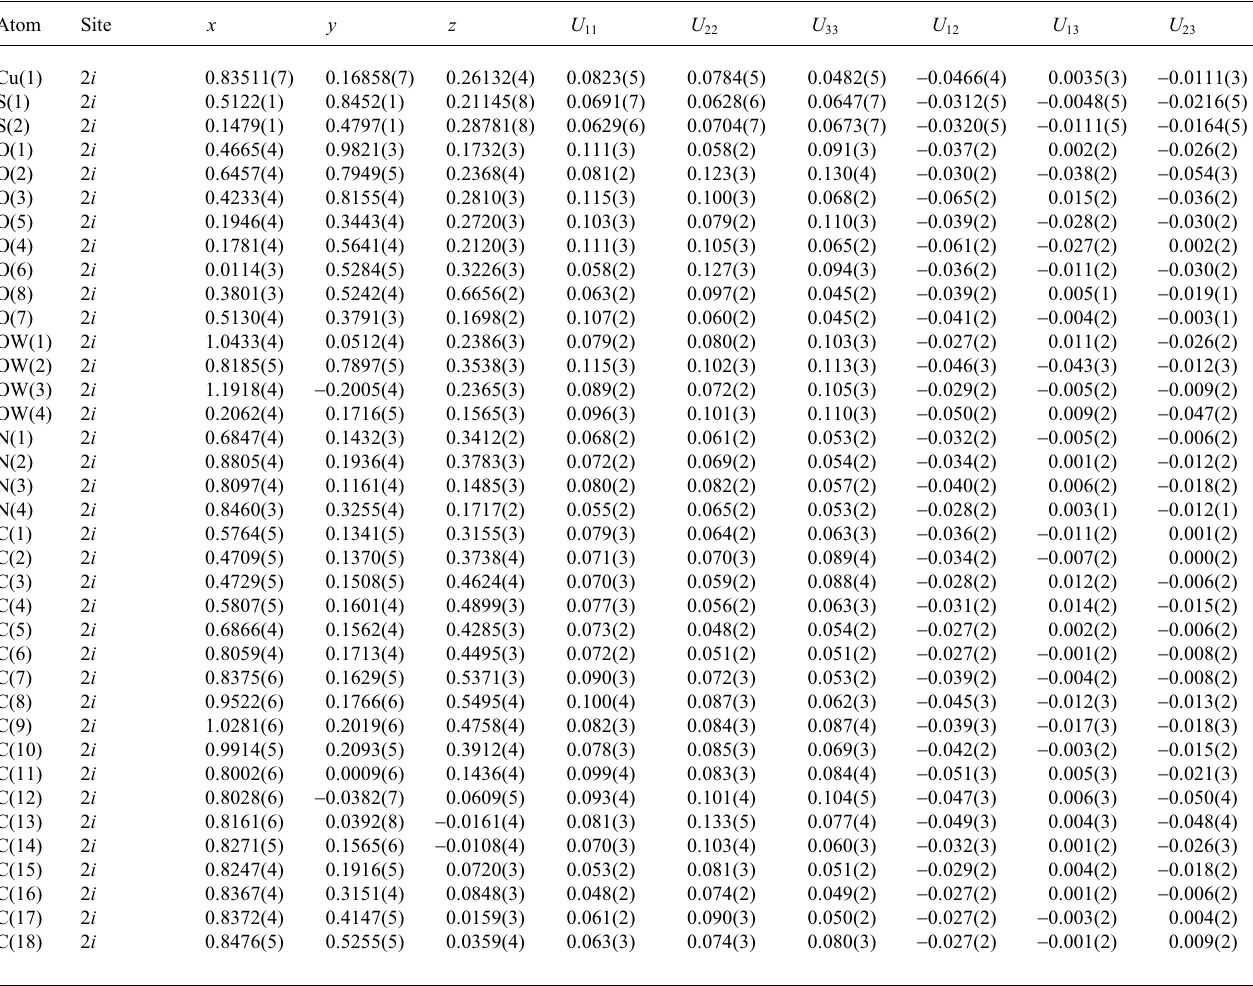
Table 3. Atomic coordinates and displacement parameters (in Å 2 ).